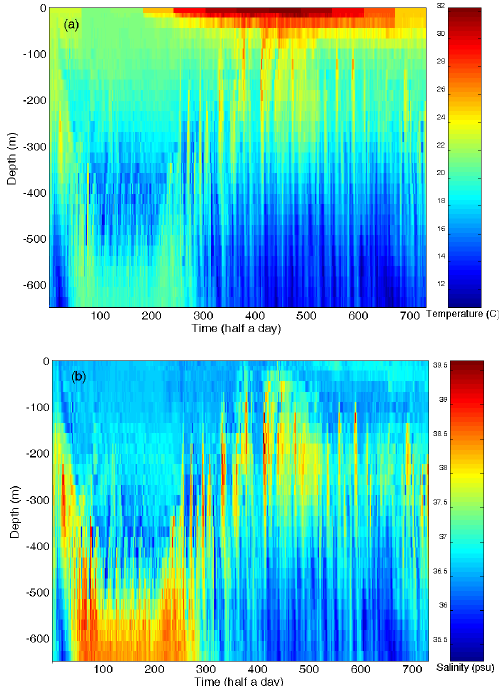
Fig. 19. Time-depth rate of changes of temperature (a) and salinity (b) , at a station off the coast of the Oman Sea located at 57 ◦ E and 24.7 ◦ N. The horizontal axis is scaled from January to December.